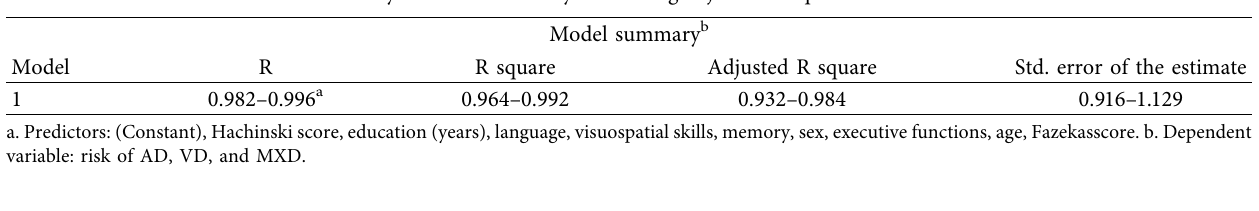
Table 5: Descriptive statistics showing the minimum and maximum scores of the primary input data.